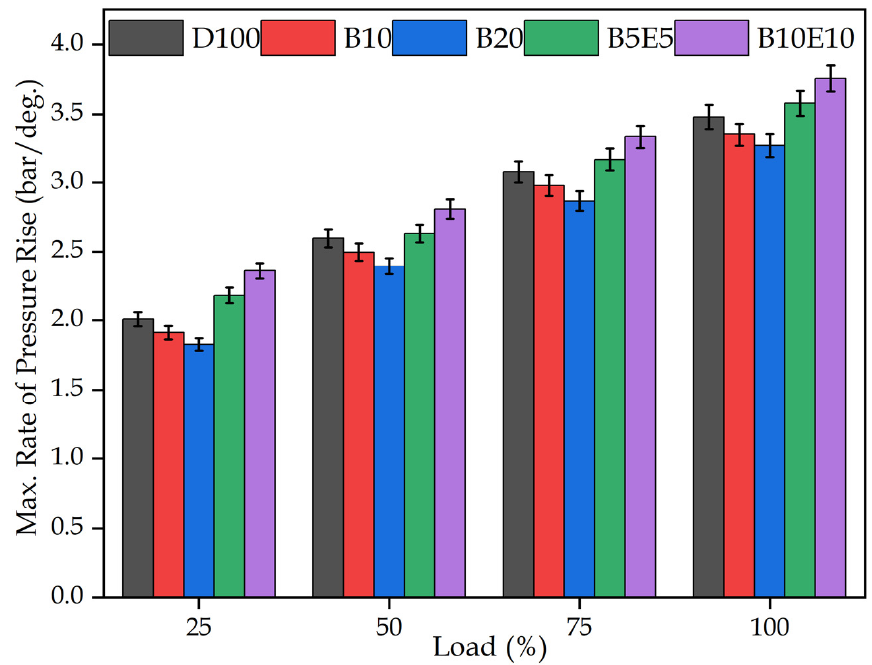
Figure 4. Maximum rate of pressure rise against engine load.